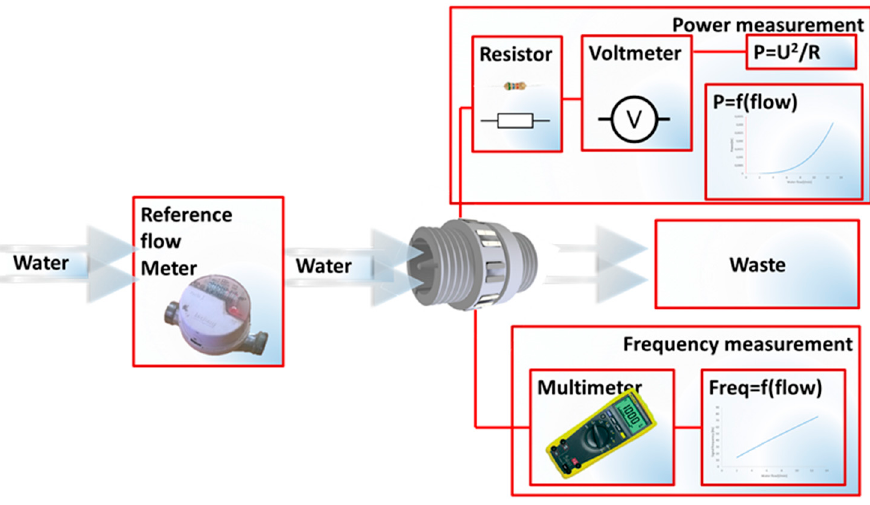
Figure 3. Characterization of water turbine with reference flow meter.